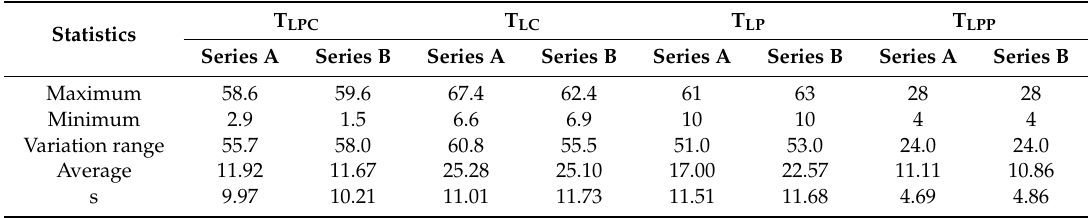
Table 10. The average values of mean basin lag times in the